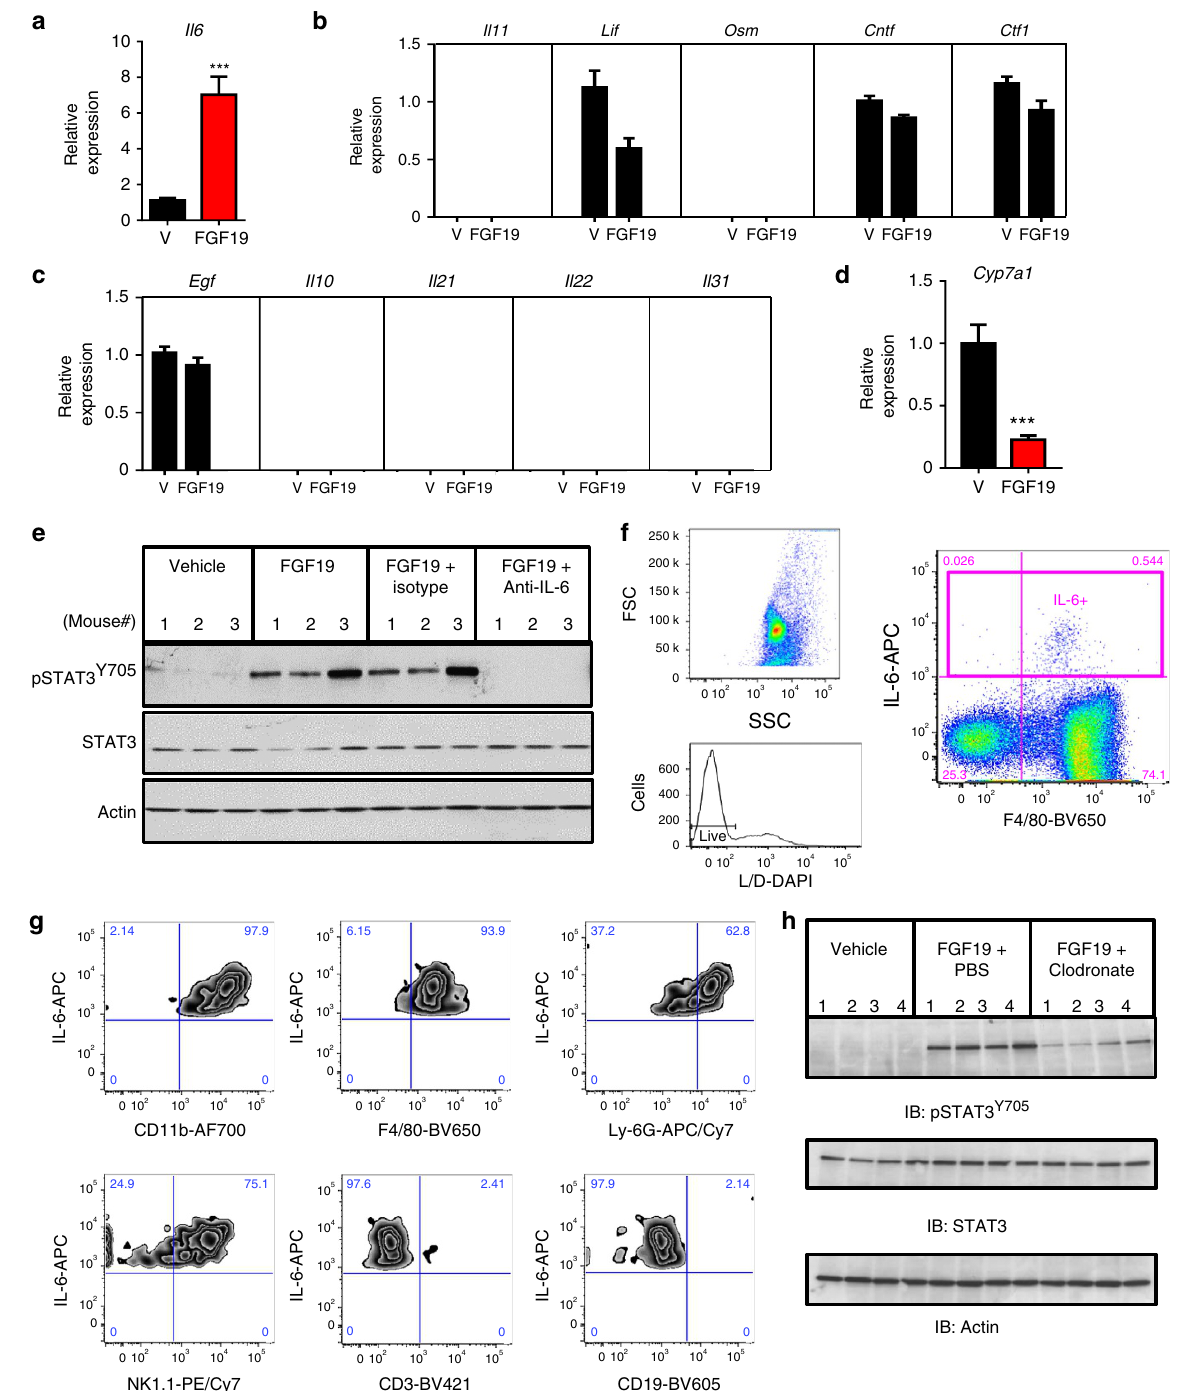
Figure 5 | Identification of secreted factor(s) mediating non-cell-autonomous activation of STAT3 by FGF19. ( a ) Hepatic IL-6 mRNA is induced in FGF19-treated db/db mice. 11 B 12-week old db/db mice received an intraperitoneal injection of 1mgkg (cid:3) 1 FGF19 or vehicle (V), and livers were